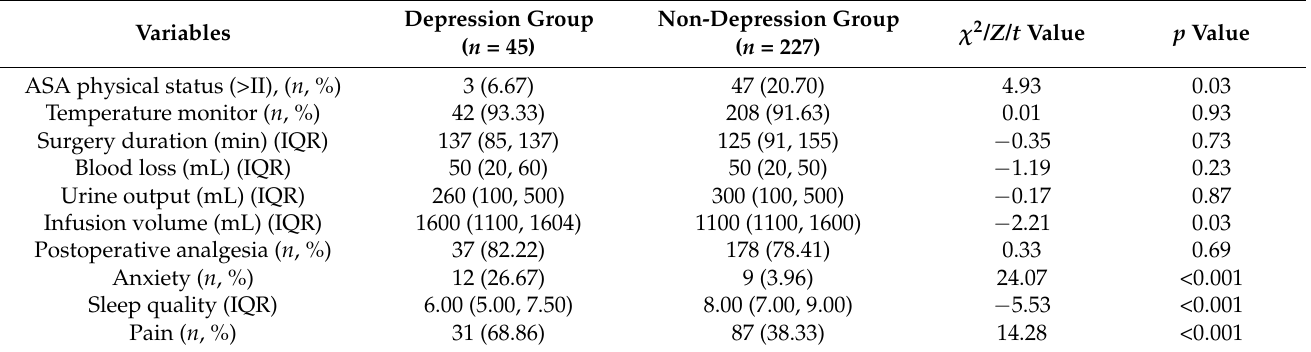
Table 2. Intraoperative and postoperative characteristics of patients with and without depres- sive symptoms.